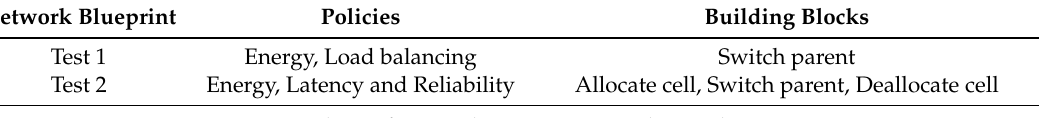
Table 3. Table showing for each test the resulting primitives when applying the Whisper algorithm.